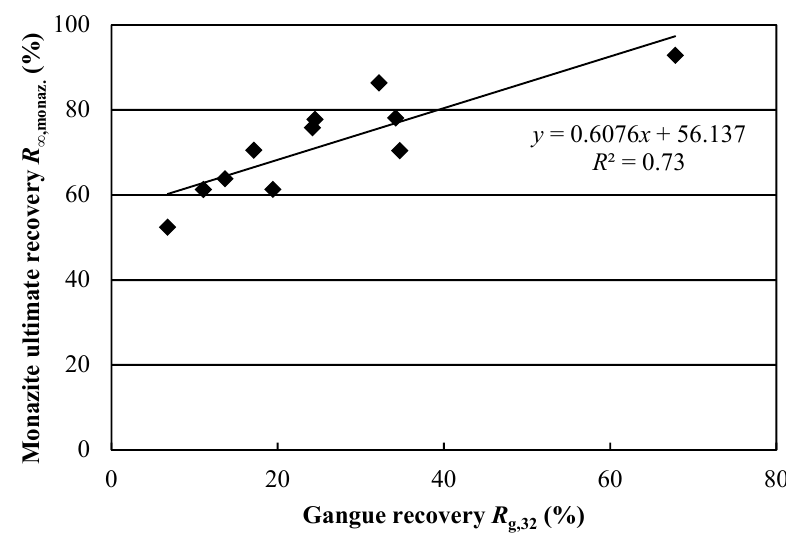
Figure 7. Monazite ultimate recovery R ∞ , monaz. as a function of gangue recovery R g,32.